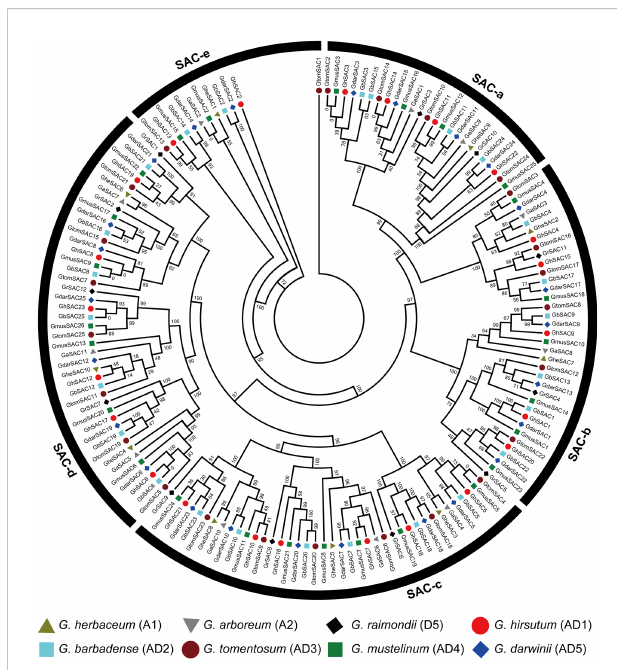
FIGURE 1 Phylogenetic analysis of cotton SAC genes. Phylogenetic tree among 157 SAC genes from three diploids ( G. herbaceum , G. arboreum , and G. raimondii ) and fi ve tetraploids ( G. hirsutum , G. barbadense , G. tomentosum , G. mustelinum , and G. darwinii ) cotton species. The pre fi xes Ghe. Ga, Gr, Gh, Gb, Gt, Gm, and Gd represents G. herbaceum , G. arboreum , G. raimondii , G. hirsutum , G. barbadense , G. tomentosum , G. mustelinum and G. darwinii respectively.